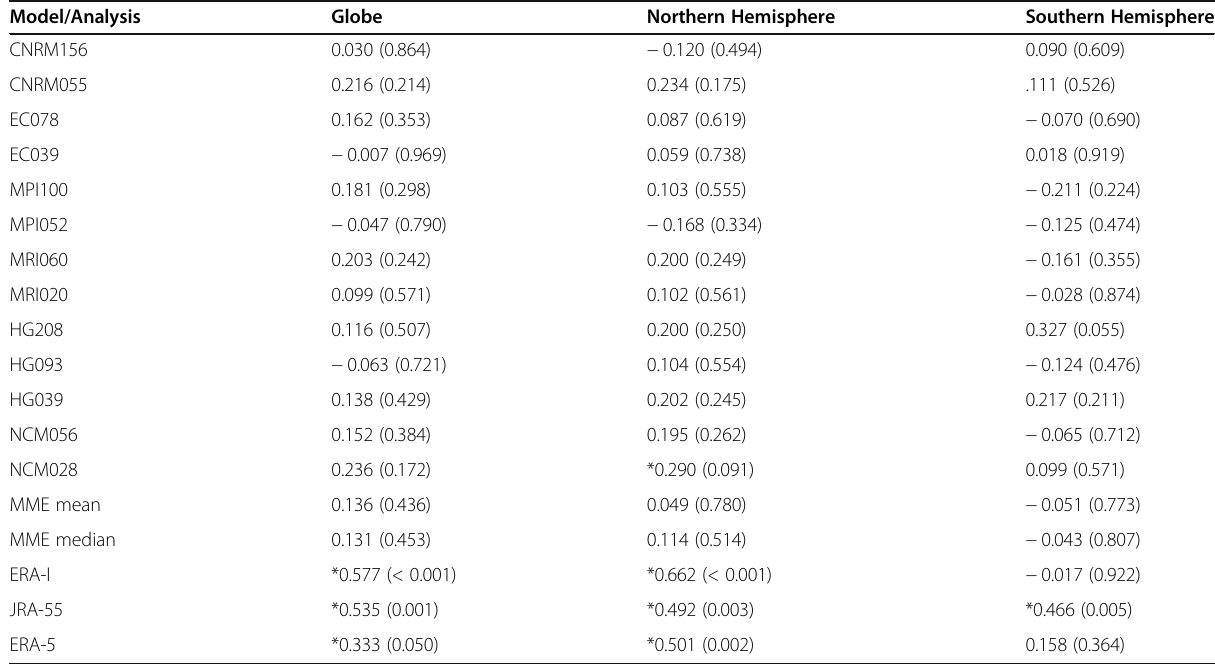
Table 2 Spearman ’ s rank correlations between TC genesis frequencies in HighResMIP multi models and in reanalyses, and IBTrACS. Spearman ’ s rank correlations were calculated from 1980 to 2014. An asterisk indicates that a correlation is statistically significant at the 90% confidence level (at least). P values are indicated in parentheses